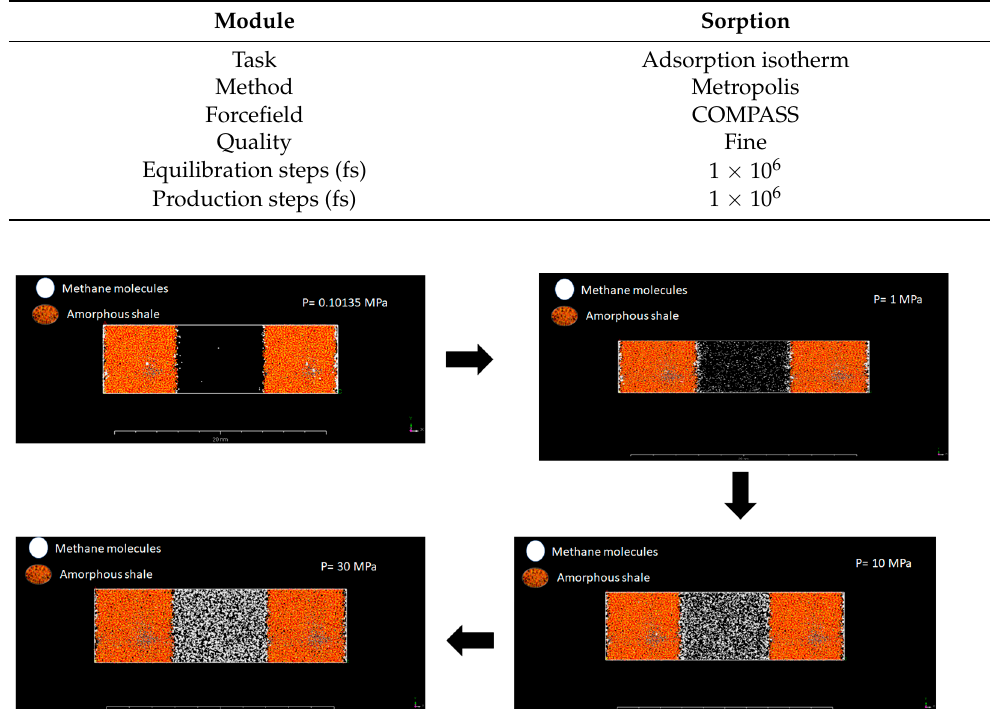
Table 2. Configuration of adsorption isotherm measurements.